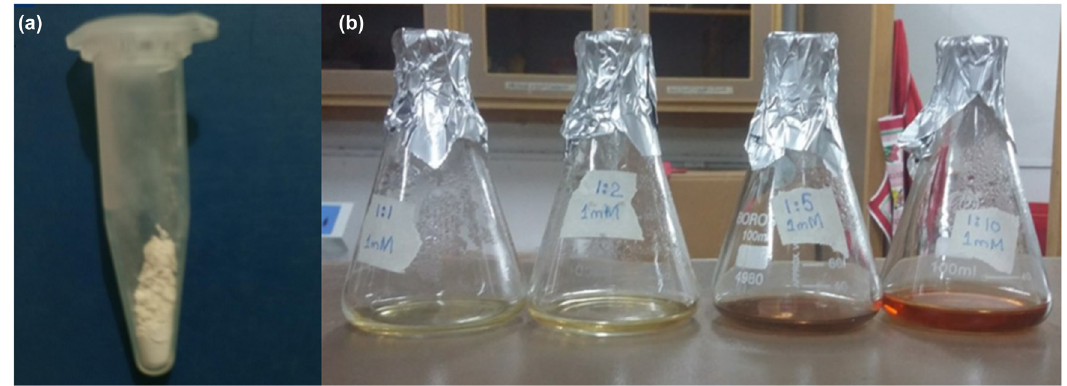
Figure 1: ( a ) Dried pale white precipitates of ZnO - NPs; ( b ) color change after the Ag - NP synthesis at di ff erent